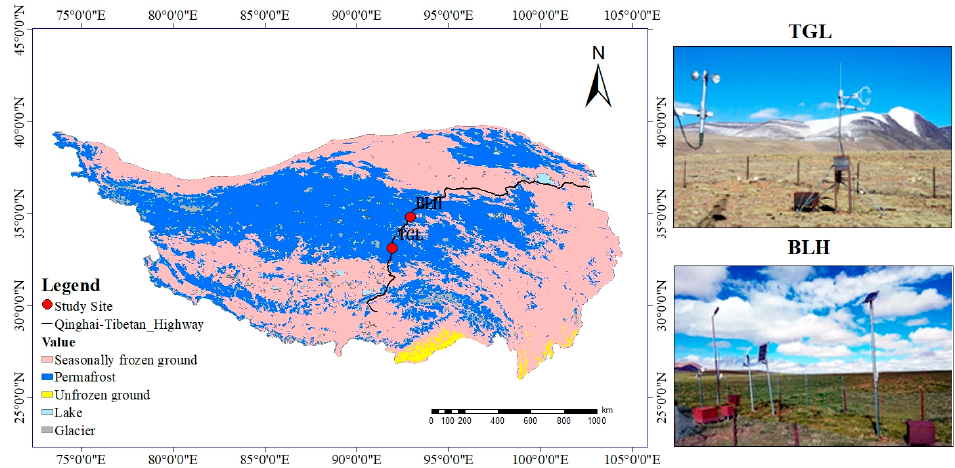
Figure 1. The location of the studied monitoring sites. The frozen ground map data were derived from [5].